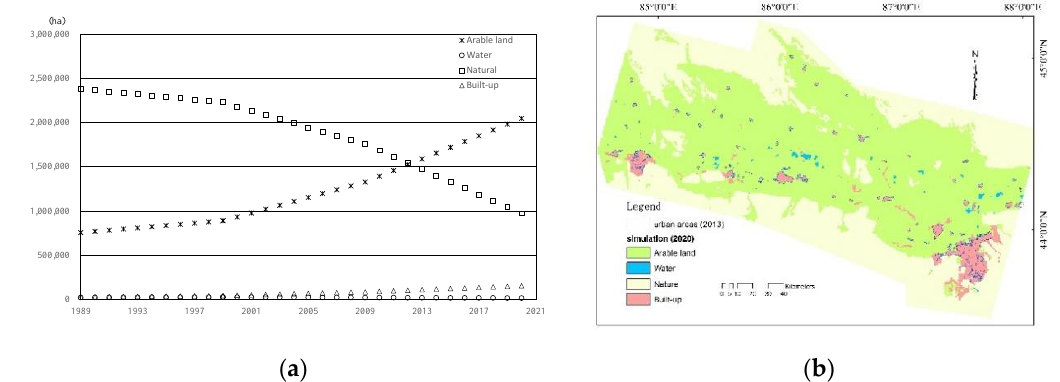
Figure 6. ( a ) Land use demand from 2013 to 2020. ( b ) Simulation results of the land requirements of trend in 2020.